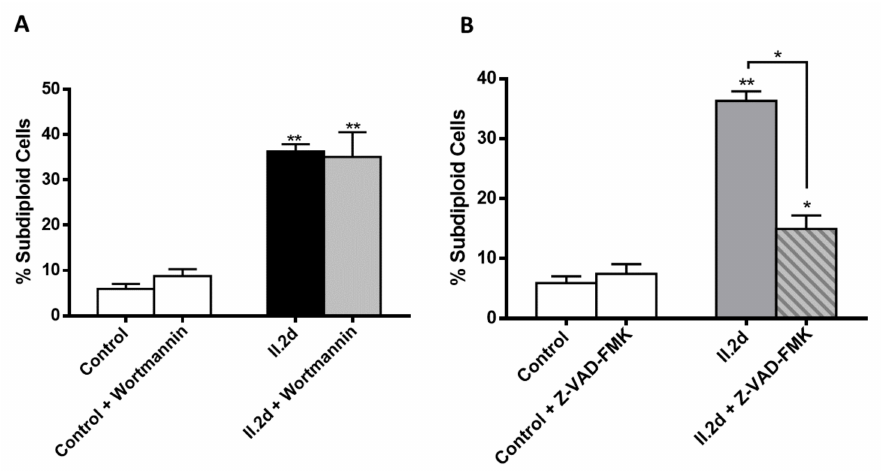
Figure 9. Z-VAD-FMK ( B ) but not wortmannin ( A ) prevented MCF-7 cells from II.2d induced cell death. * Statistical significance with values of p < 0.05; ** statistical significance with values of p < 0.01. To further confirm the programmed cell death pathway, the expression levels of several markers of autophagy [39] and apoptosis [40] were evaluated by Western blot. Beclin-1 and LC3B were determined, and autophagic flux was also assessed by testing SQSTM1/p62. As shown in Figures 10 and 11, increased levels of Beclin-1 and LC3B were detected in MCF-7 cells when treated with I.1f (80 µ M during 48 h) and I.2f (30 µ M for 24 h), indicating autophagy. In addition, the autophagic flux, SQSTM1/p62, was downregulated confirming the autophagy process. Phosphorylation of AMPK and JNK was also studied because they have shown to be implicated in autophagy-mediated cell death [27]. As expected, both compounds induced JNK and AMPK phosphorylation.